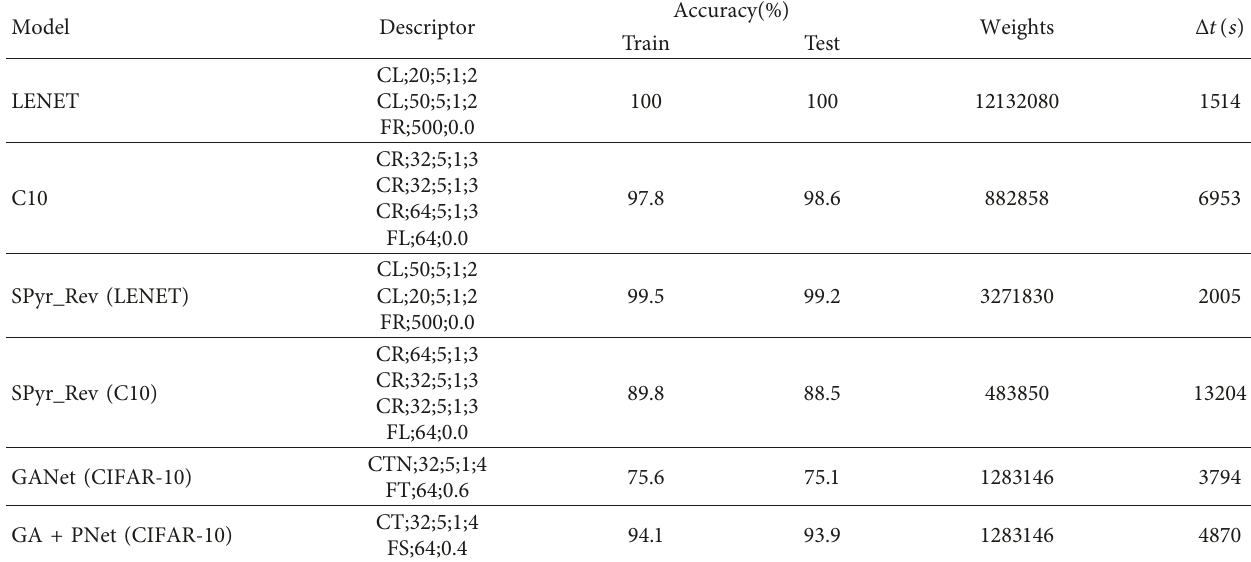
Table 8: Optimized and reference models (Cifar-10).